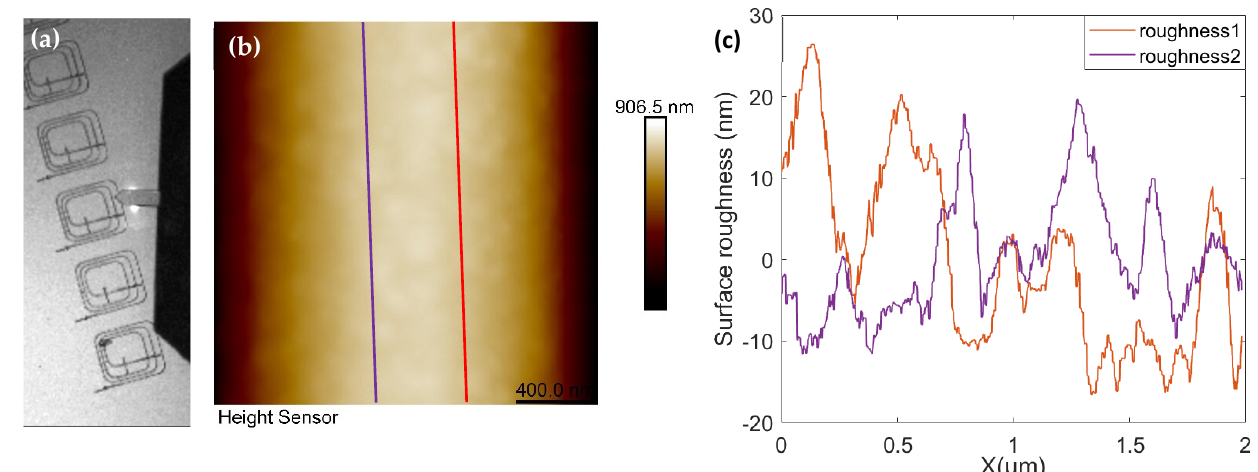
Figure 8. ( a ) Fabricated spiral waveguide, in the process of scanning with AFM tip, ( b ) AFM image of the waveguide’s curved surface topography, and ( c ) two line profiles along waveguide direction revealing its surface roughness.